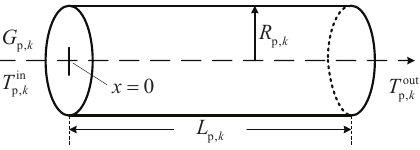
Figure 2. General structure of a single